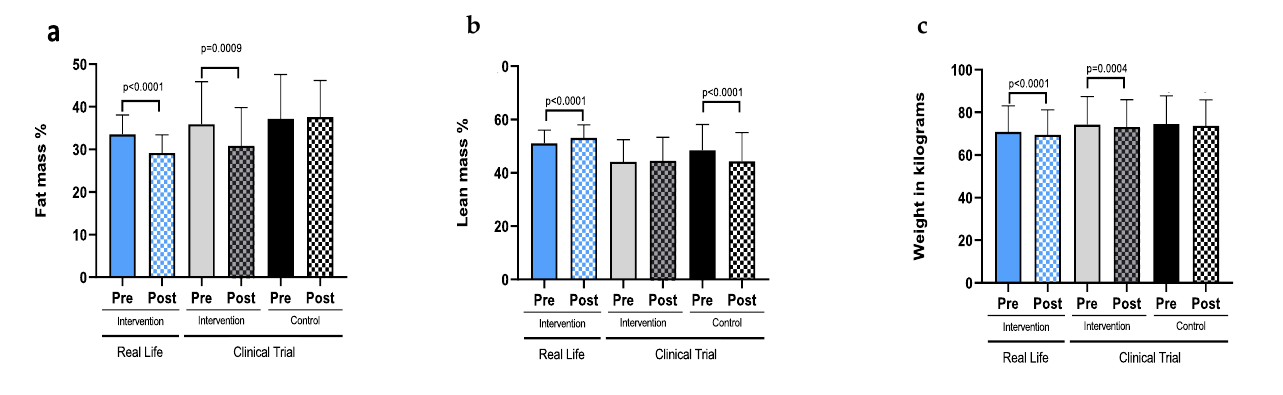
Figure A2. Abdominal and brachial girths in old individuals before and after a six-month interven- tion. ( a ) Abdominal girth. ( b ) Brachial girth. . Real-Life Intervention n = 50, Clinical Trial Interven- tion n = 51, Clinical Trial Control n = 49. Bars represent mean ± SD. Statistical analysis was performed with the Student ’ s t test for paired samples and the Wilcoxon test for non-parametric samples.